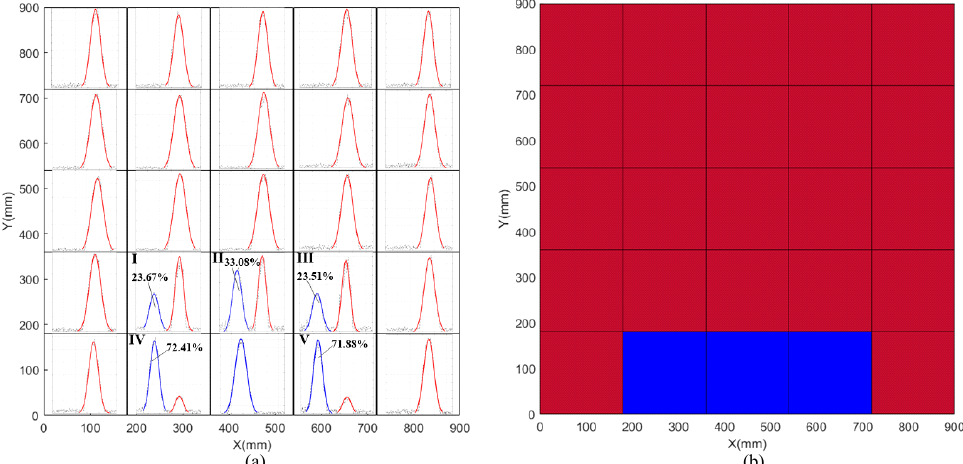
Figure 9. Imaged targets. ( a ) Relative location of two plates. ( b ) Front view of ( a ).